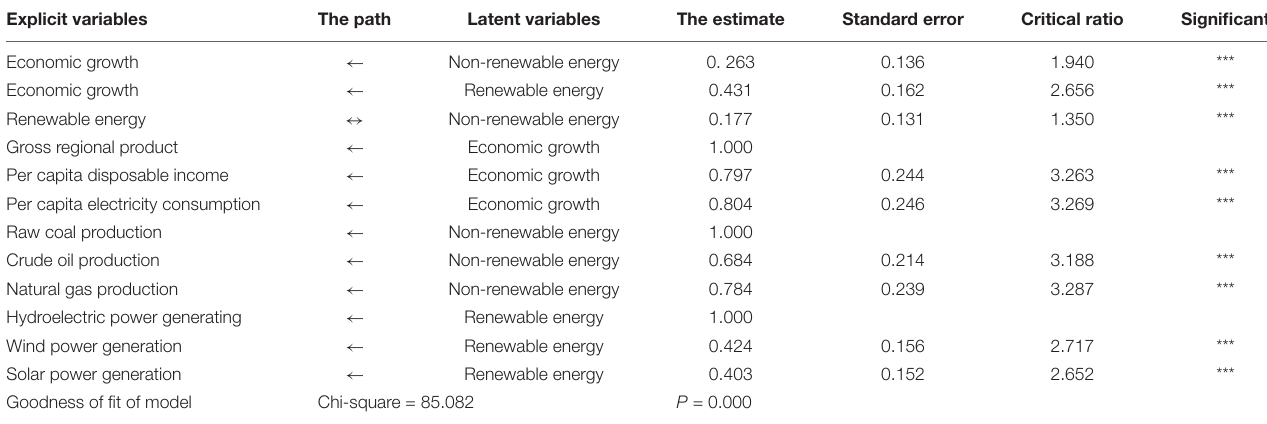
TABLE 6 | The parameter estimates of the structural equation of the impact of comprehensive energy development on regional economic growth. Explicit variables The